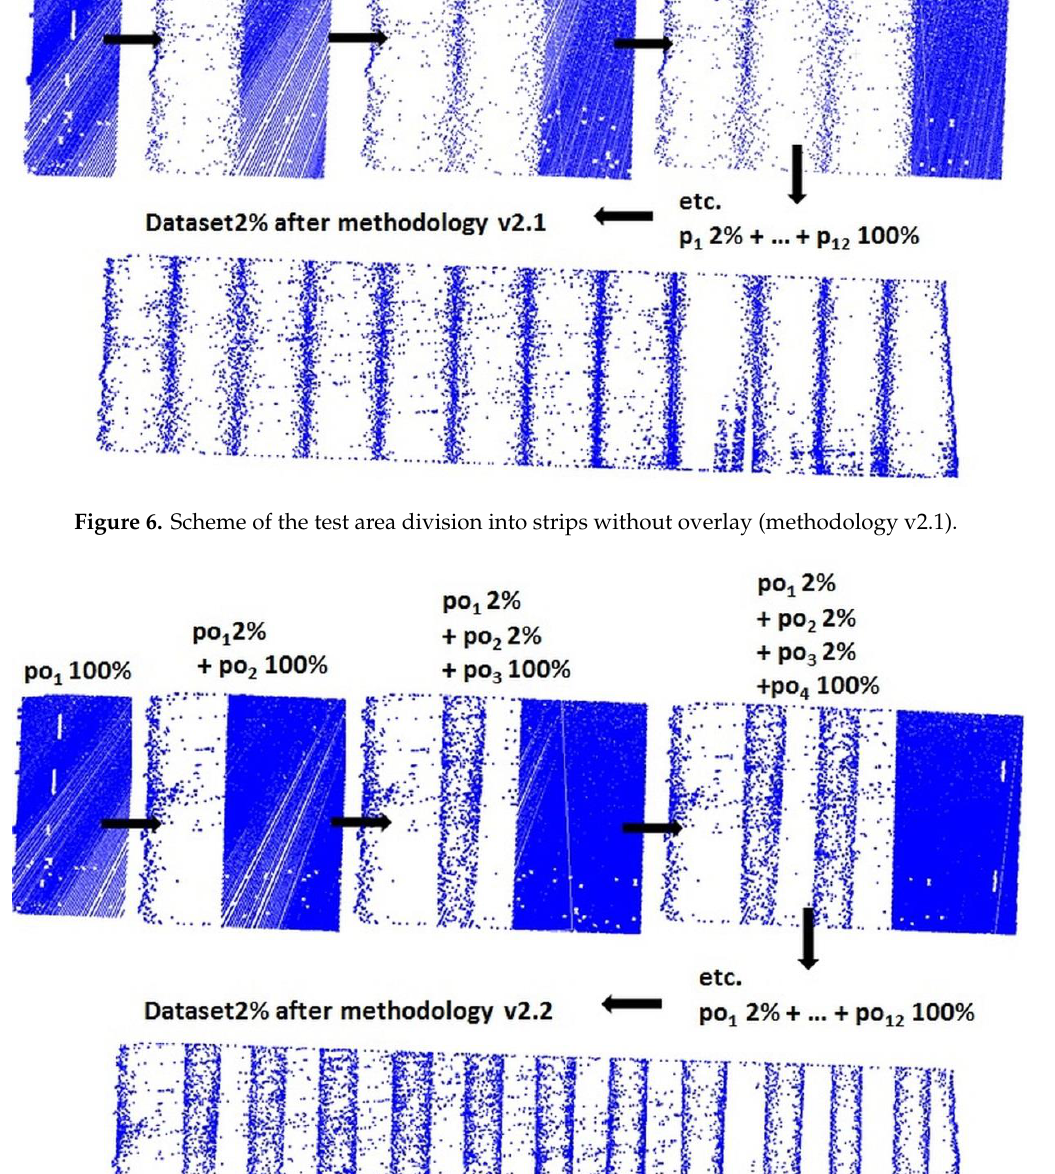
Figure 8. Optimized test area (13,976 points). In the case of reducing the whole data set presented in Figure 8, we observed that the points remained in characteristic places of the studied area. The statistical characteristics of the datasets obtained by methodology v2 are shown in Table 2. Table 2. Statistical characteristics for datasets in methodology v2. (Where: H – height, R – range, STD – standard deviation) Number of points H min. [m] H max. [m] R [m] STD [m] Optimized dataset